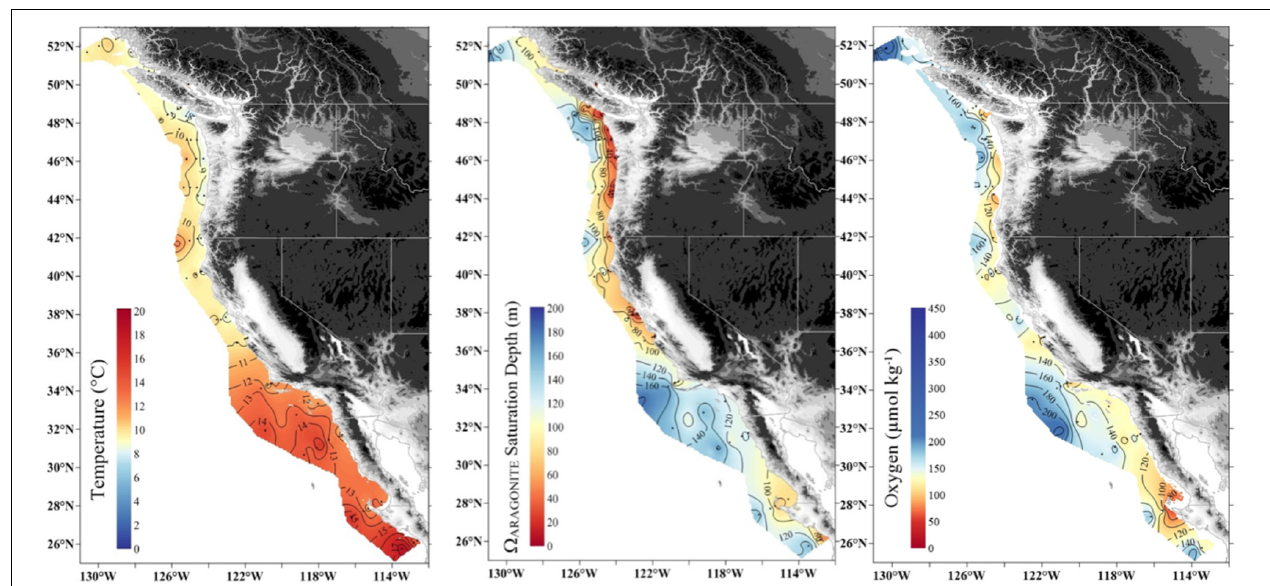
FIGURE 1 | Large-scale gradients of temperature (50 m), depth of aragonite saturation ( (cid:127) ar = 1) and oxygen concentration (100 m) along the United States West Coast in May–June